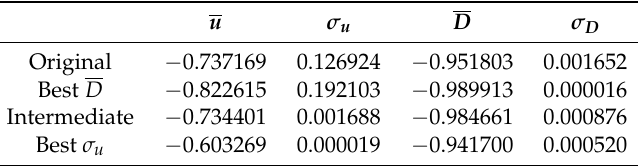
Table 1. Objective function values for some selected